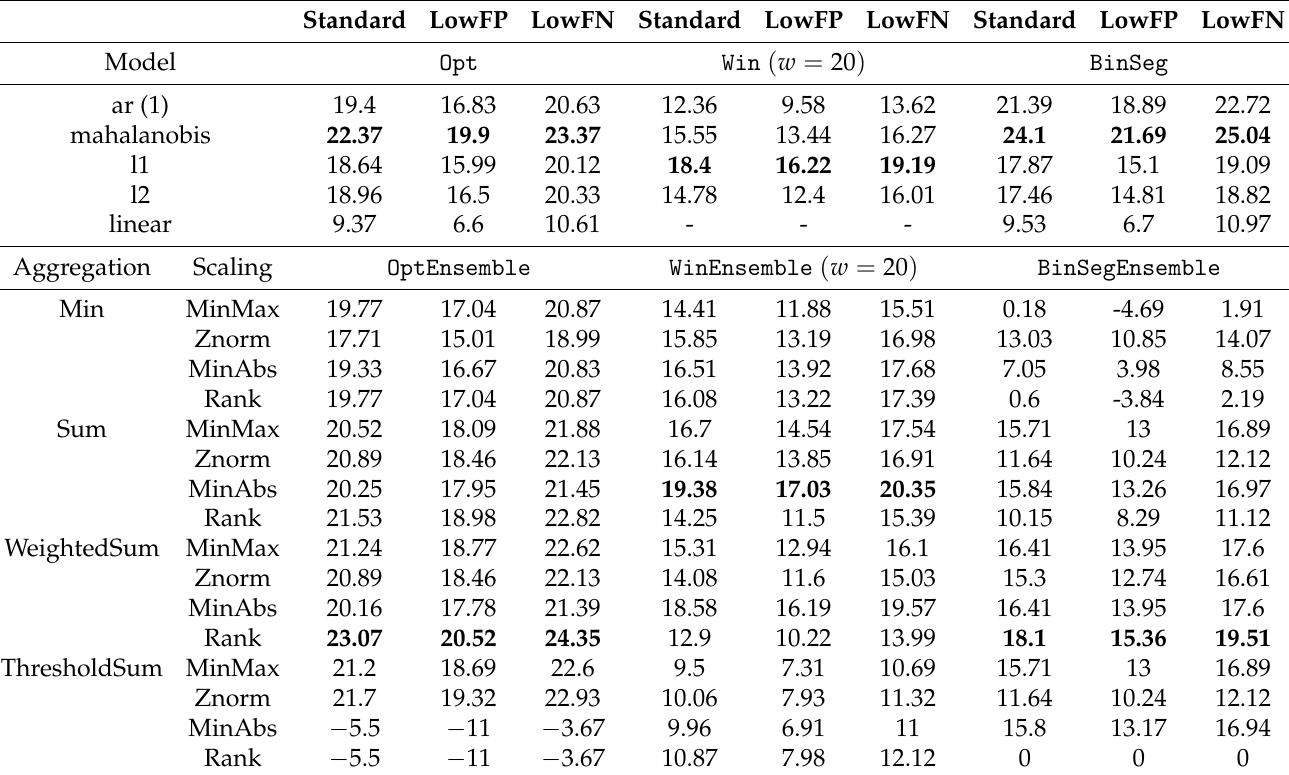
Table 3. NAB scoring algorithm (higher is better) results of the CPD algorithms on